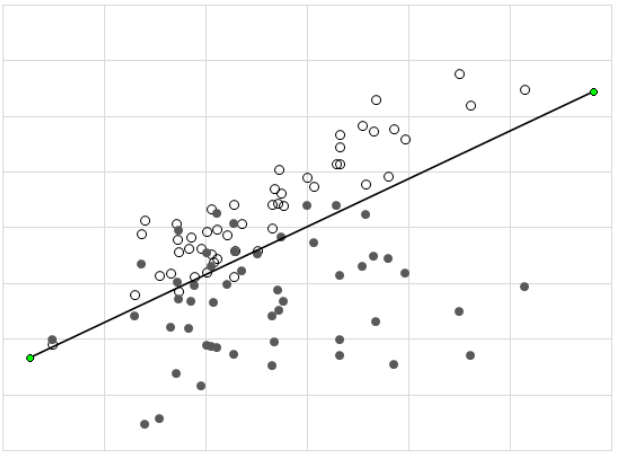
Figure 8. Combination of two arbitrary metrics using a straight line to discriminate an image in the simplest case (white: Positive, black: Negative)